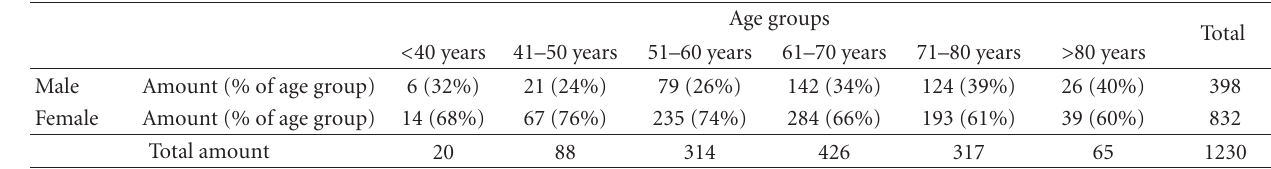
Table 3: Distributions of gender according to the age groups.